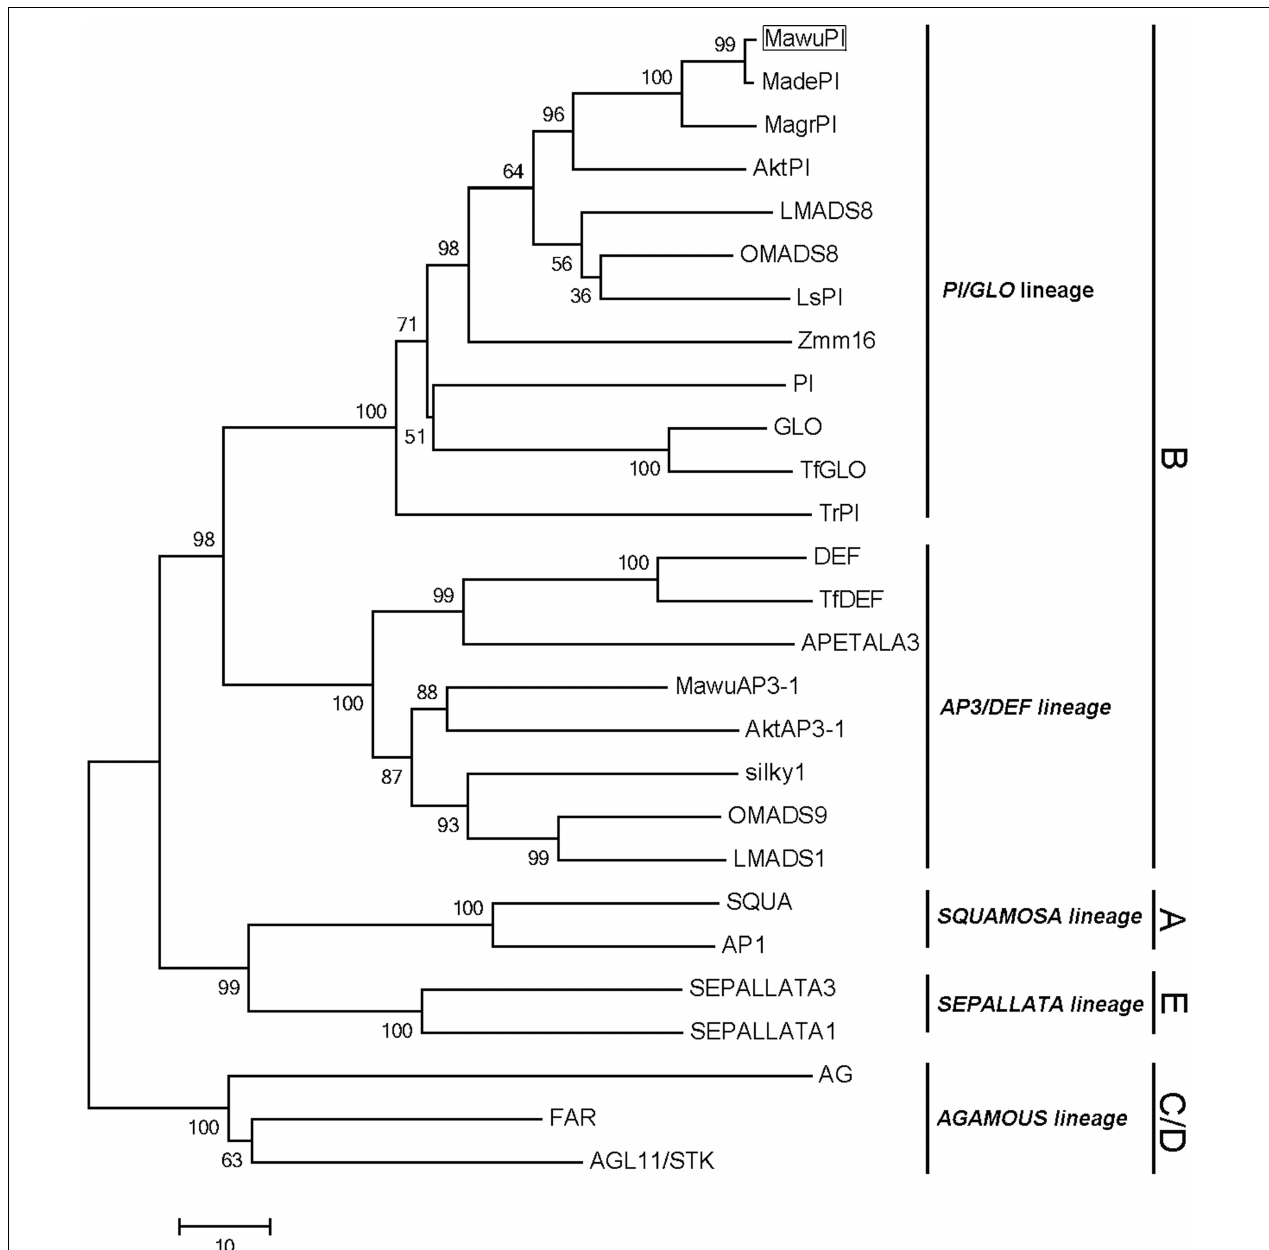
FIGURE 2 | Phylogenetic analysis of PI/GLO lineage. The MAwuPI protein sequence is blasted with twenty B-class genes from other angiosperms, with two A-class genes, two C-class genes, one D-class gene and two E-class genes as outgroup. The MAwuPI is